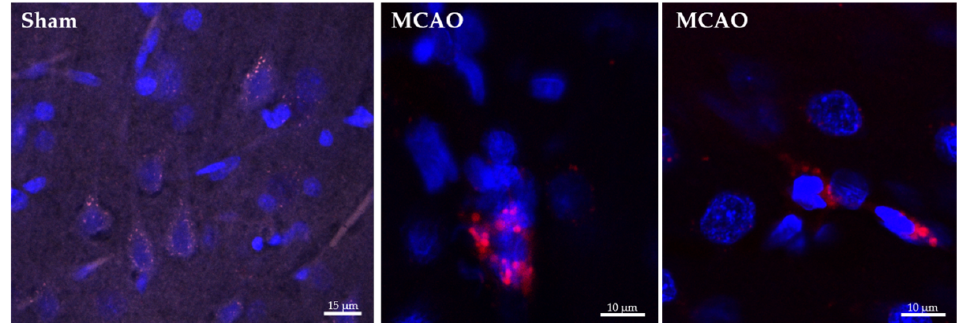
Figure 3. Confocal microscopy images of histological sections of the infarcted zone from sham (left) and MCAO (middle and right) animals taken 24 h after the systemic injection of the hyaluronate NPs. Several nervous cells, whose nuclei are stained in blue with DAPI, show empty NPs grouped as cytoplasmic red vesicles due to its labelling with rhodamine fluorescent dye.